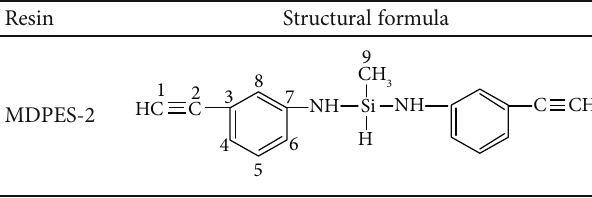
Table 1: The structural formula of MDPES-2 resin.